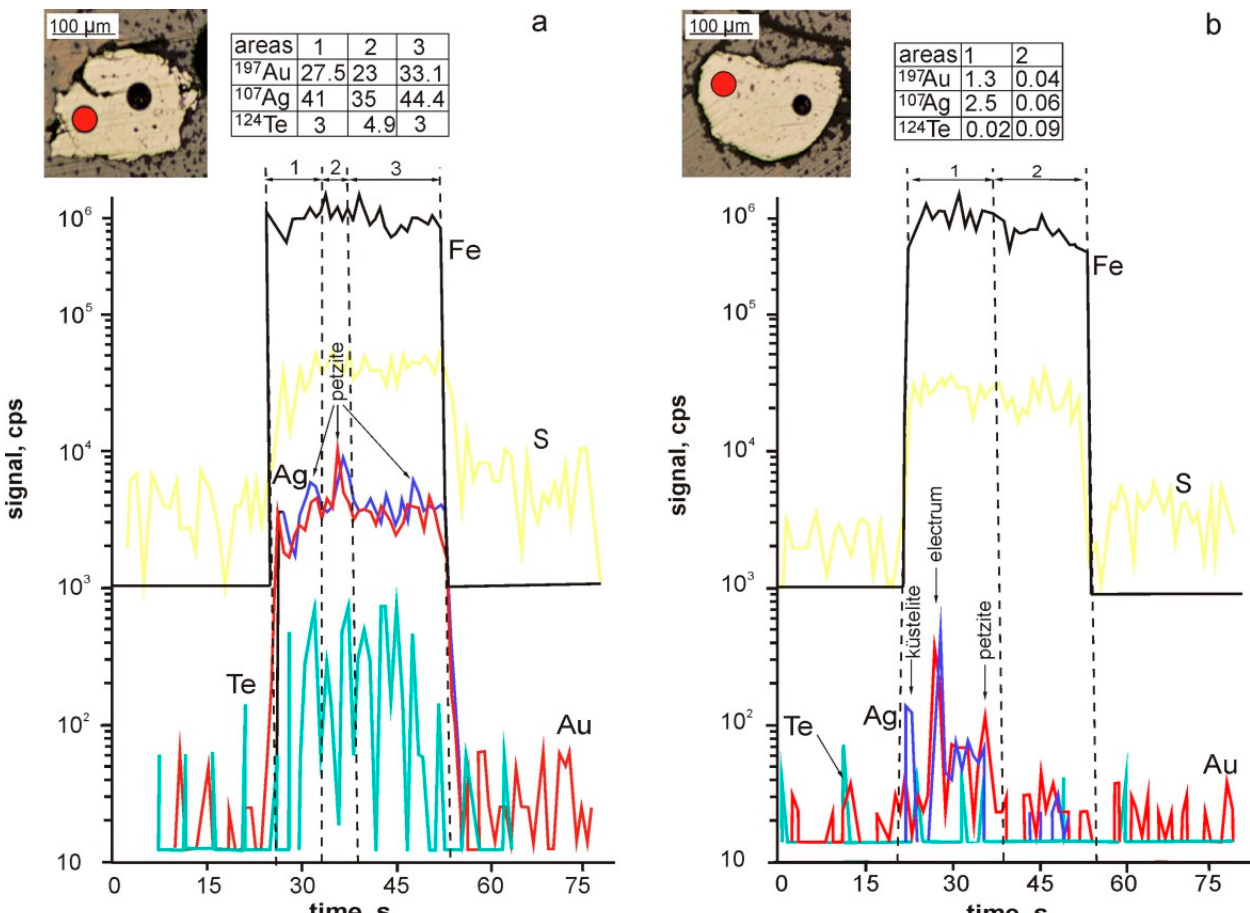
Figure 17. Composition of pyrite from the gold-telluride assemblage obtained by the LA-ICPMS method for the Petropavlovsk deposit: ( a ) tiny inclusions of native gold and petzite are evenly distributed, the gold-sulphide assemblage, sample PP 308/2. ( b ) A few peaks are probably related with inclusions of native gold or küstelite and petzite, the gold-telluride assemblage, sample PP 309/5. Note (here and in Figure 19): the graphs show the main (Fe, S) and some minor (Au, Ag, Te) elements in pyrite.